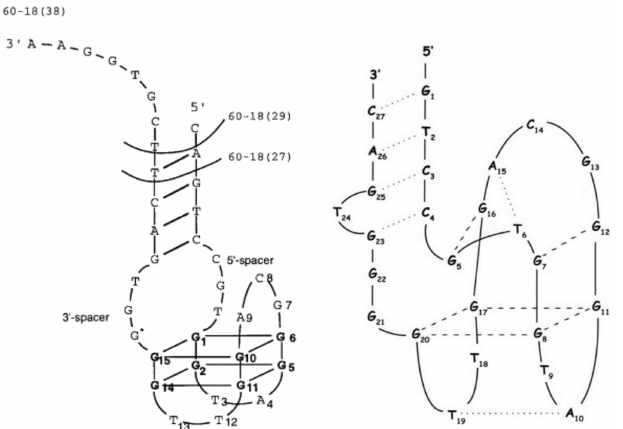
Figure 4. The structure of 60-18(29) (HD22(29)) and 60-18(27)) (HD22(27)) aptamer developed by Tasset et al. [54] ( left ) and HD22(27) structurally characterized by Krauss et al. [71] ( right ). Left: bold letters correspond to G-quadruplex core, G * indicates residue, which is important for efficient interactions with thrombin. Right: dotted lines—H-bonding, dashed lines—G-G Hoogsteen interactions. Reproduced by permission from Elsevier, © 1997 Academic Press Limited and IUCr Journals, © 2013 International Union of Crystallography Printed in